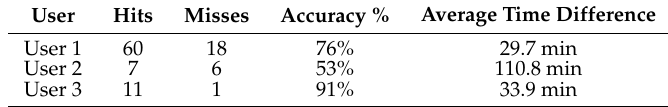
Table 7. Prediction accuracy of the simple traversing-based prediction